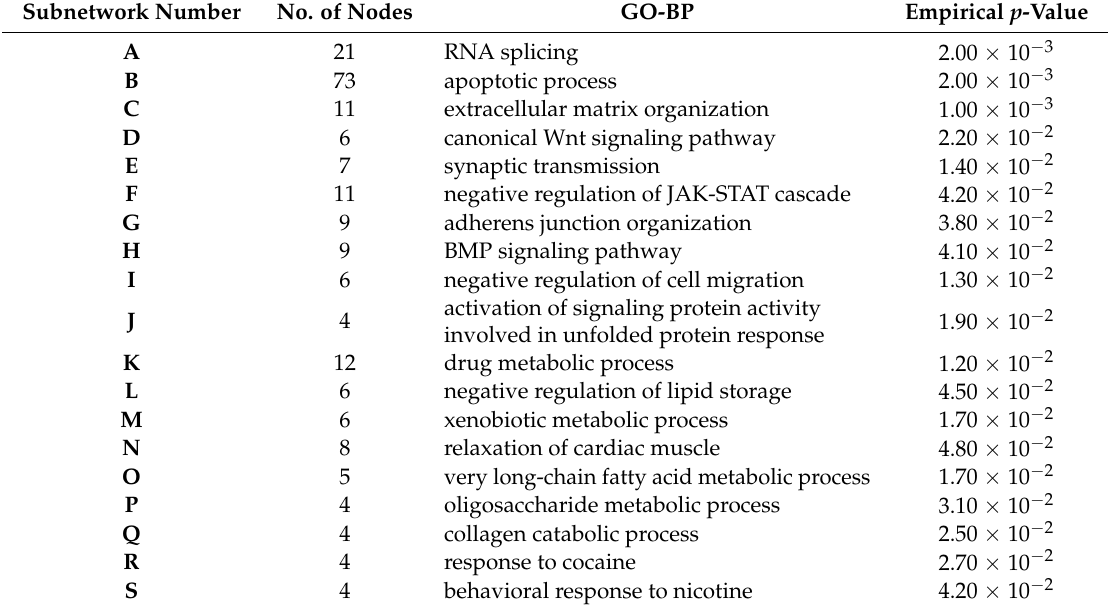
Table 3. Summary of differentially regulated sub-networks disturbed by bufadienolide-like chemicals. Subnetwork